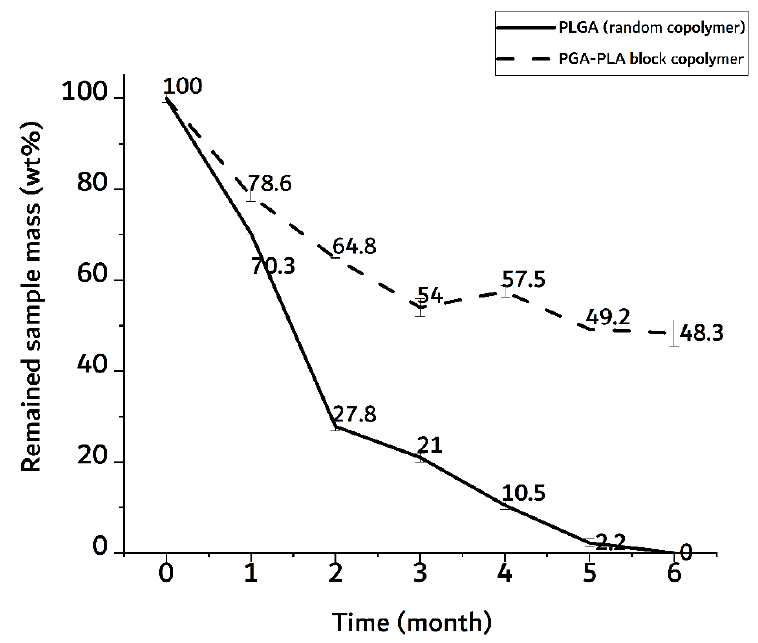
Figure 10. Weight trace of monthly extracted samples over 6 months after insertion surgery.